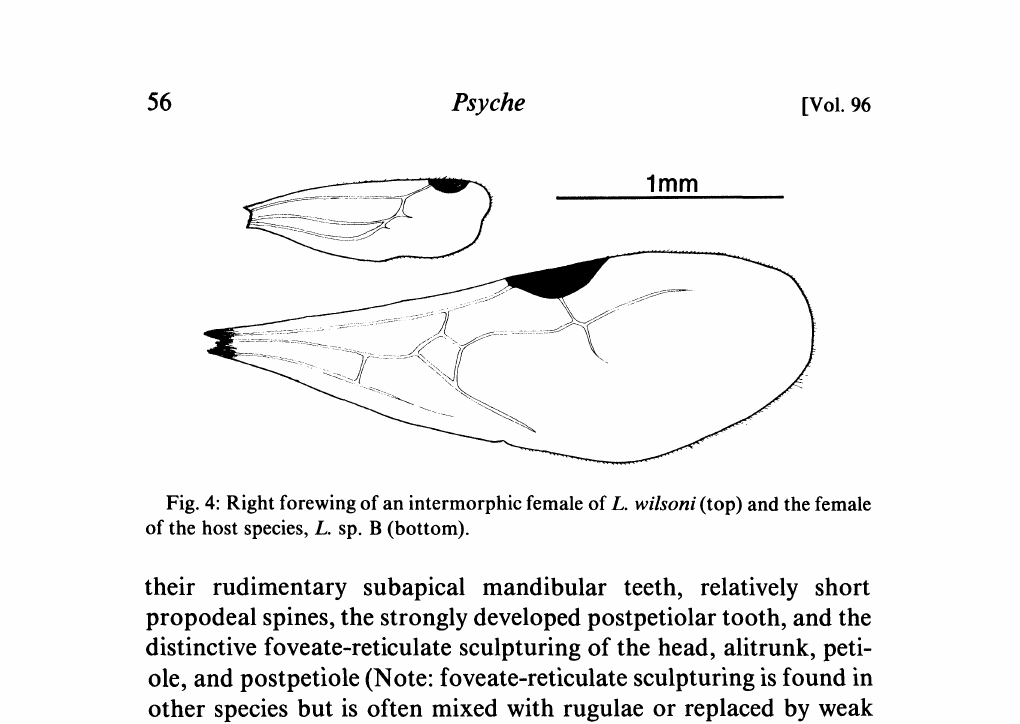
acines with this trait (the genus Harpagoxenus) are larger than